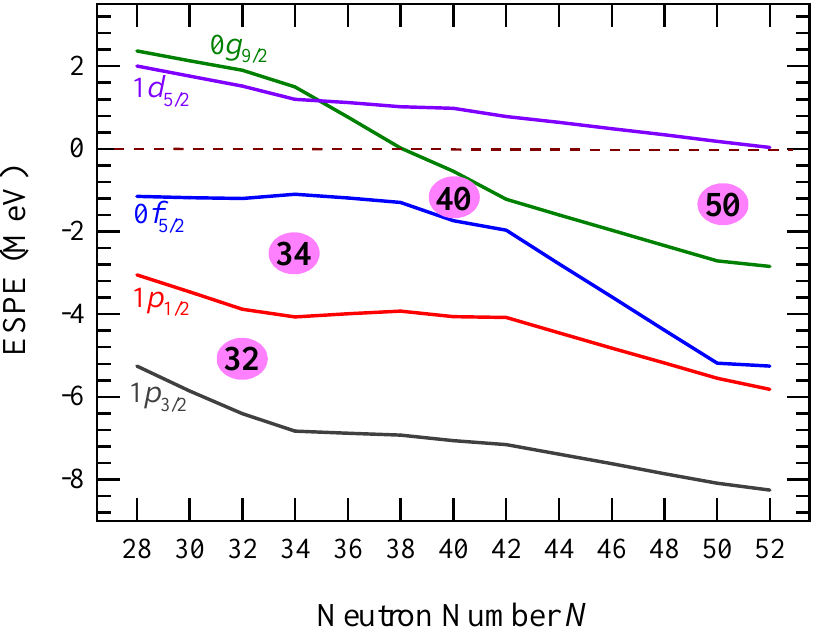
Figure 9. Neutron effective single-particle energies (ESPE) with respect to the 48 Ca core, as a function of neutron number. The V low − k Λ = 2.6 fm − 1 CD-Bonn interaction is utilized (with permissions from Ref.